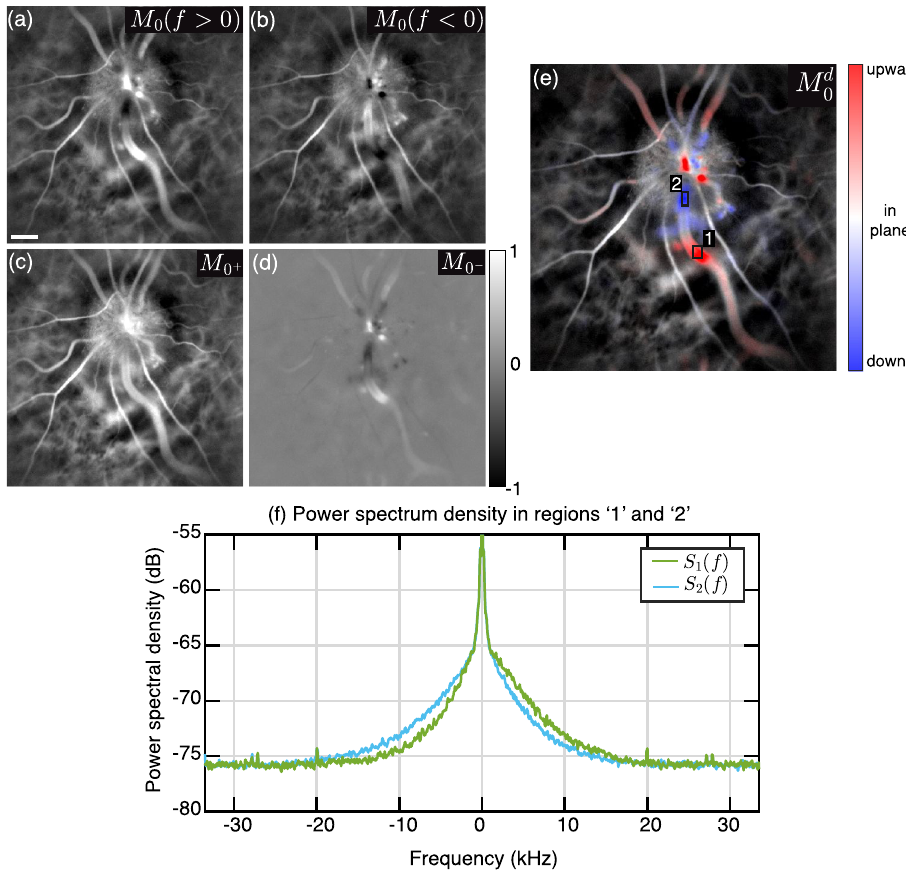
Figure 1. Directional blood flow contrast. ( a , b ) Power Doppler images from the positive and negative parts of the Doppler spectrum. ( c , d ) Sum and difference of those two images. ( e ) Directional power Doppler image on which upward and downward flow give red and blue contrasts, respectively. ( f ) Doppler power spectrum density in two regions of a blood vessel where the local flow has upward (green trace) and downward components (blue trace),